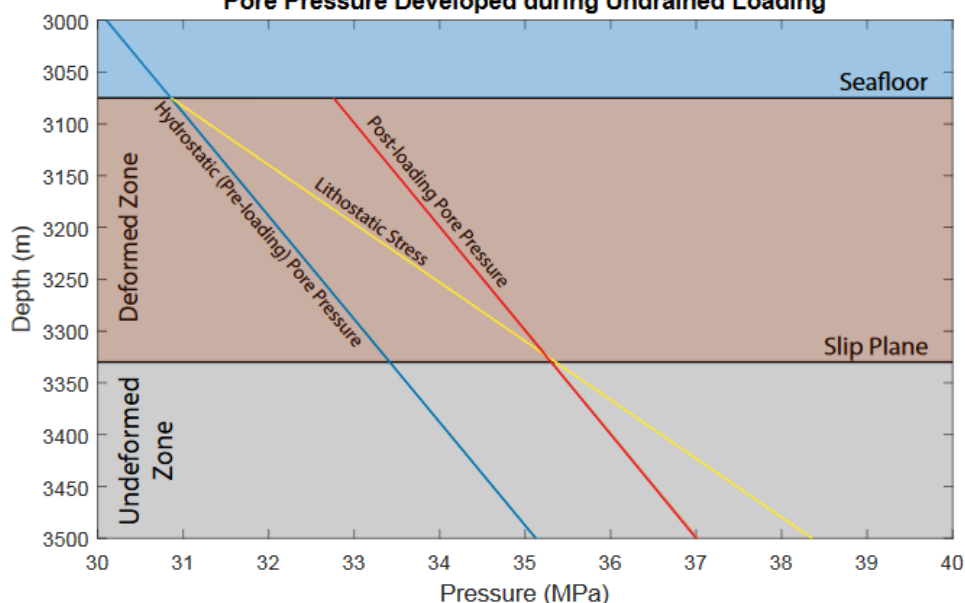
Figure 6. Theoretical pore pressure immediately after the deposition of the large 44-N landslide blocks on the seafloor. Post-loading pore pressure (yellow) exceeds lithostatic stress (orange) to a depth of the slip plane identified by seismic (Figure 5). This pore pressure profile assumes initial hydrostatic pore pressure (blue) and undrained loading of the weight of the blocks.